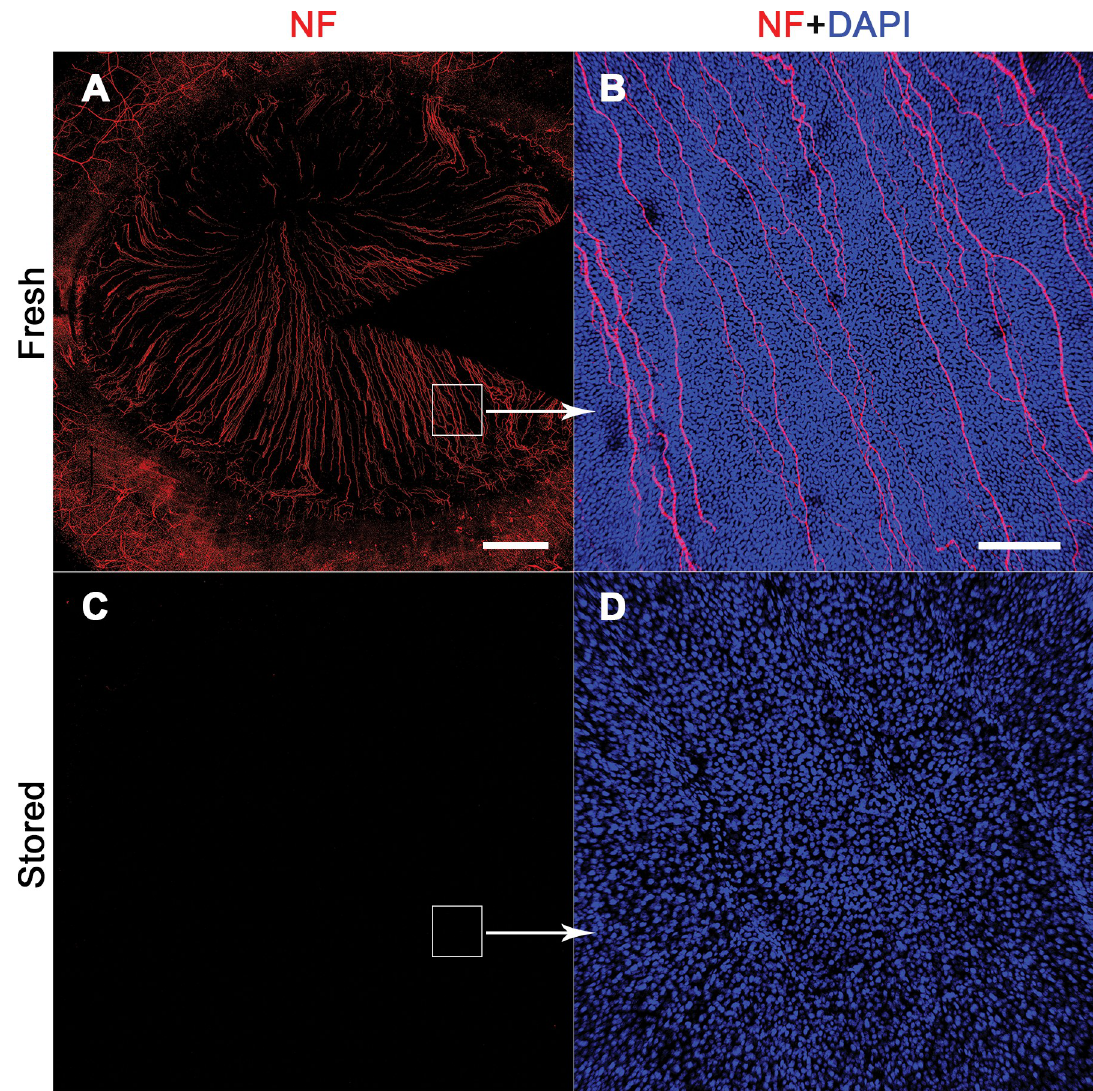
Fig 7. Disappearance of intraepithelial nerve structures after organ culture and storage in the active storage machine. Nerves were revealed by immunostaining of the Neurofilament-L (NF in red). One cornea was studied fresh, immediately after retrieval (A) and its paired cornea was studied after 14 days’ organ culture storage and 14 days’ additional storage in the active storage machine (C). (A and C) Nerve map of the whole flat-mounted cornea with its limbus and proximal conjunctiva. Scale bar: 2 mm. (B and D). Close-up of the nerves, and of epithelial cell nuclei labeled with DAPI (in blue) (x10 objective). The epithelium of the stored cornea was very disorganized and had far fewer cells. Scale bar: 200 μ